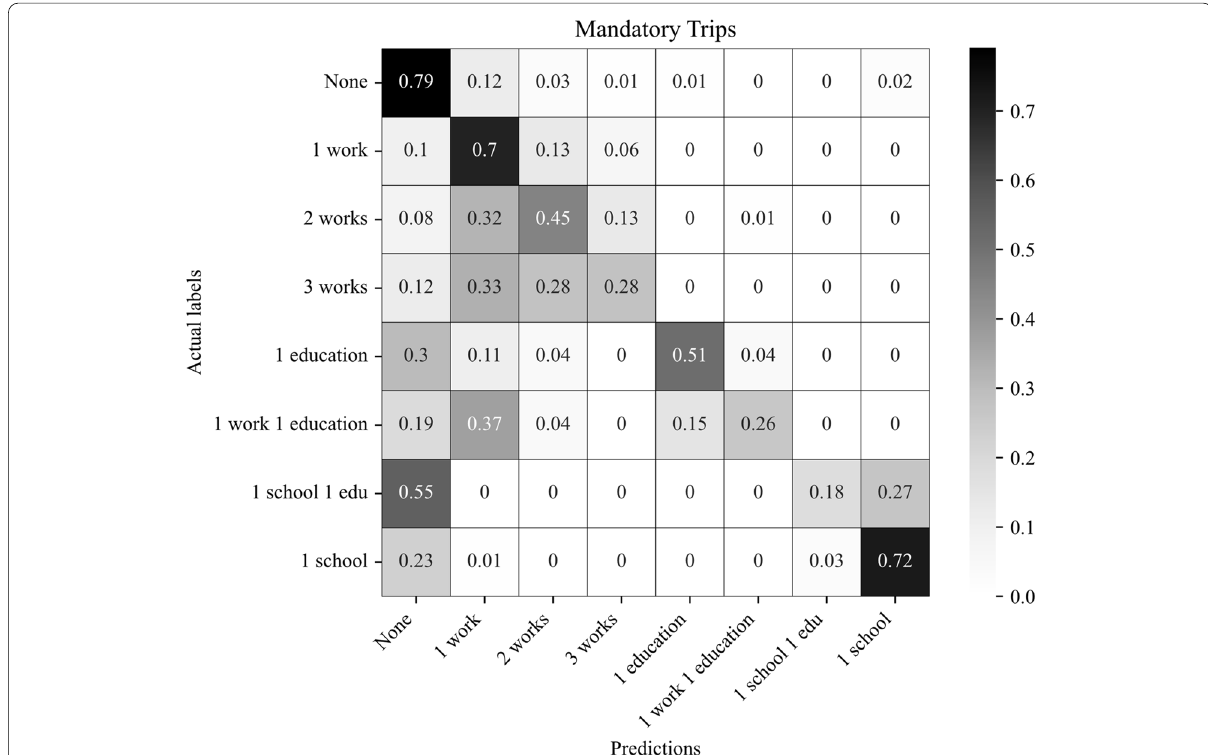
Fig. 2 The confusion matrix of the mandatory trips generation